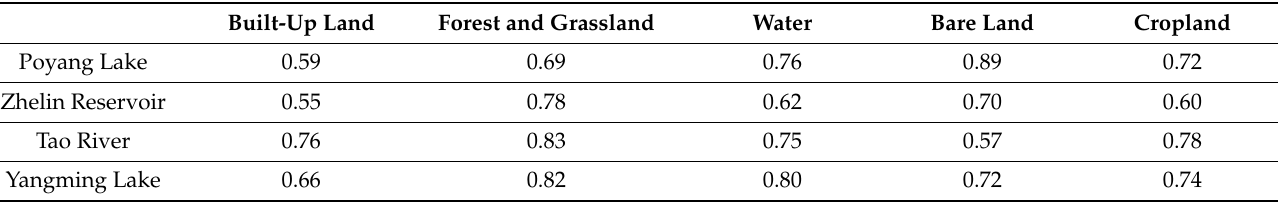
Table A2. Grey correlation of land use/cover